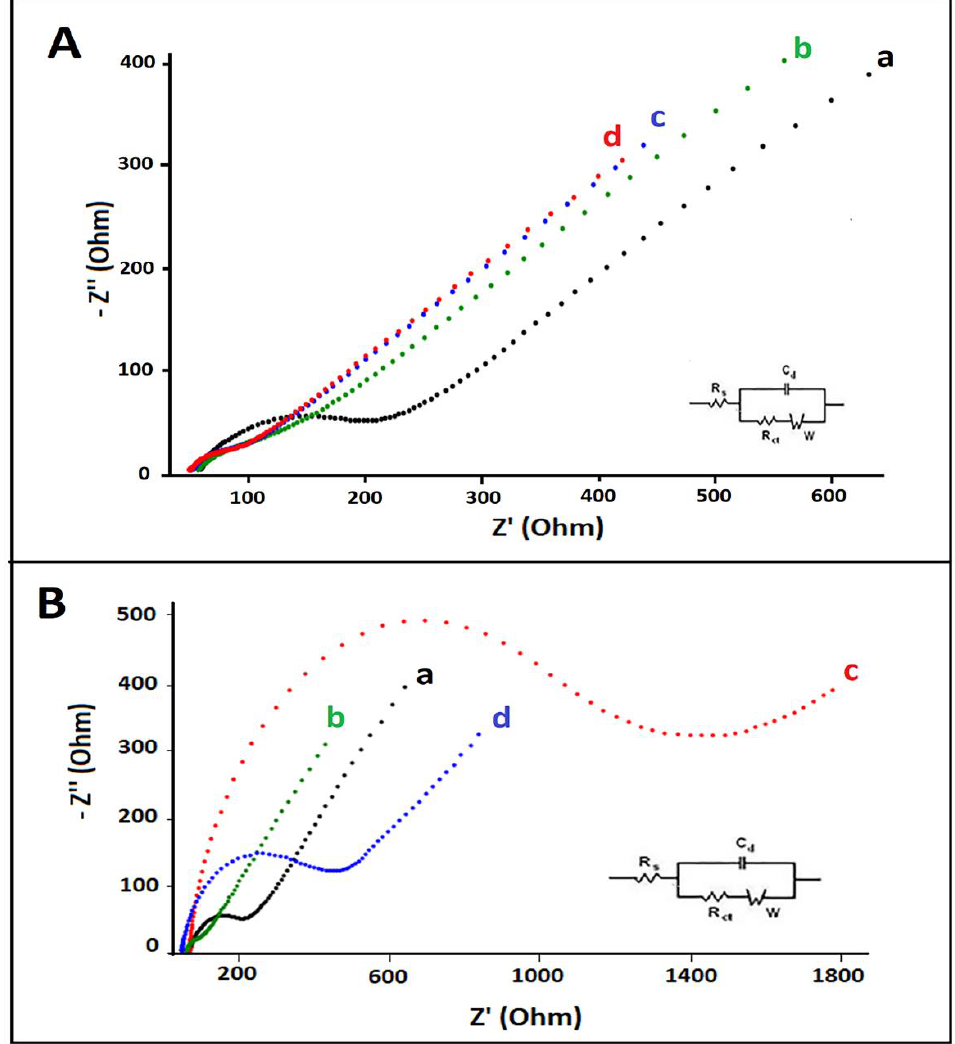
Figure 3 Figure 3. ( A ) Nyquist diagrams of (a) PGE, (b) HaP-PGE, (c) IL-PGE, and (d)